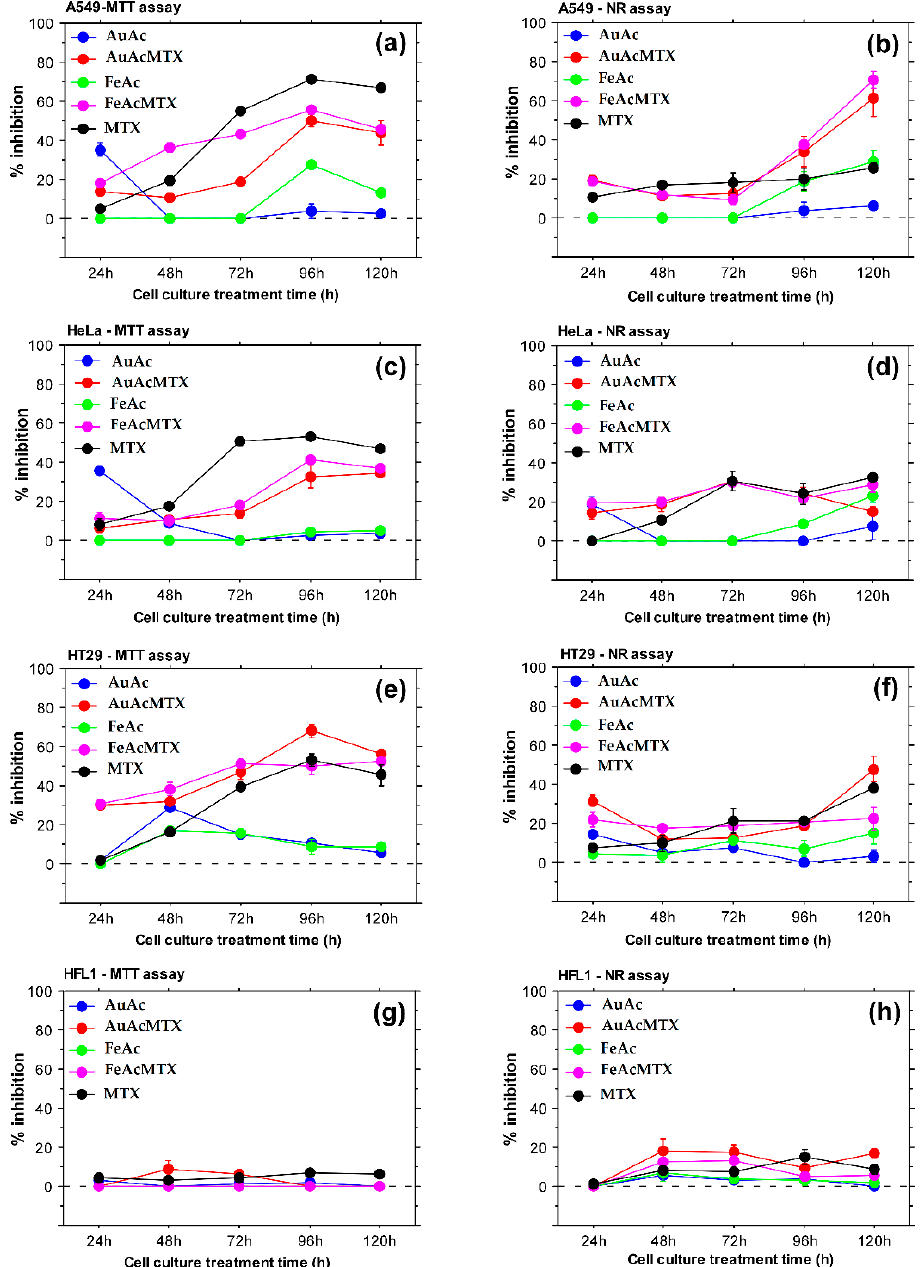
Figure 12. Longitudinal evaluation of metal nanoparticles and NPs-MTX conjugates in vitro cytotoxicity. ( a , c , e , g ) show the inhibition of cellular metabolic activity determined by MTT assay with A549 ( a ), HeLa ( c ), HT29 ( e ), and HFL1 ( g ) cells treated with 100 µ g/mL test-compound. ( b , d , f , h ) show NR assay results for A549, HeLa, HT29, and HFL1 cells, respectively, cultured in medium containing 100 µ g/mL AuAc, FeAc, AuAcMTX, FeAcMTX, and MTX for 24, 48, 72, 96, and 120 h. All samples were analyzed in